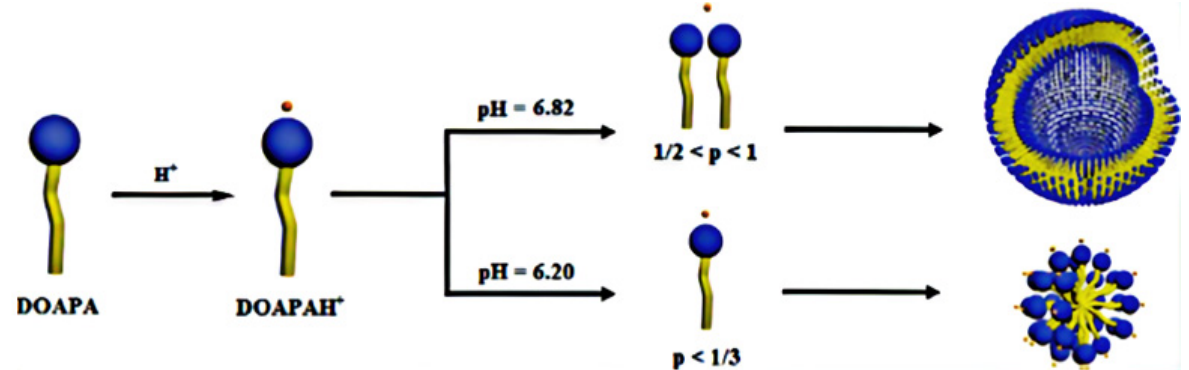
Figure 1. pH reduction changes vesicle to a spherical micelle [19].